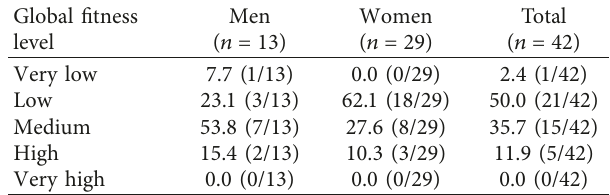
Table 3: Overall fitness level (%): global fitness level. Table 1: Age (years) and BMI (%) by sex and total number of